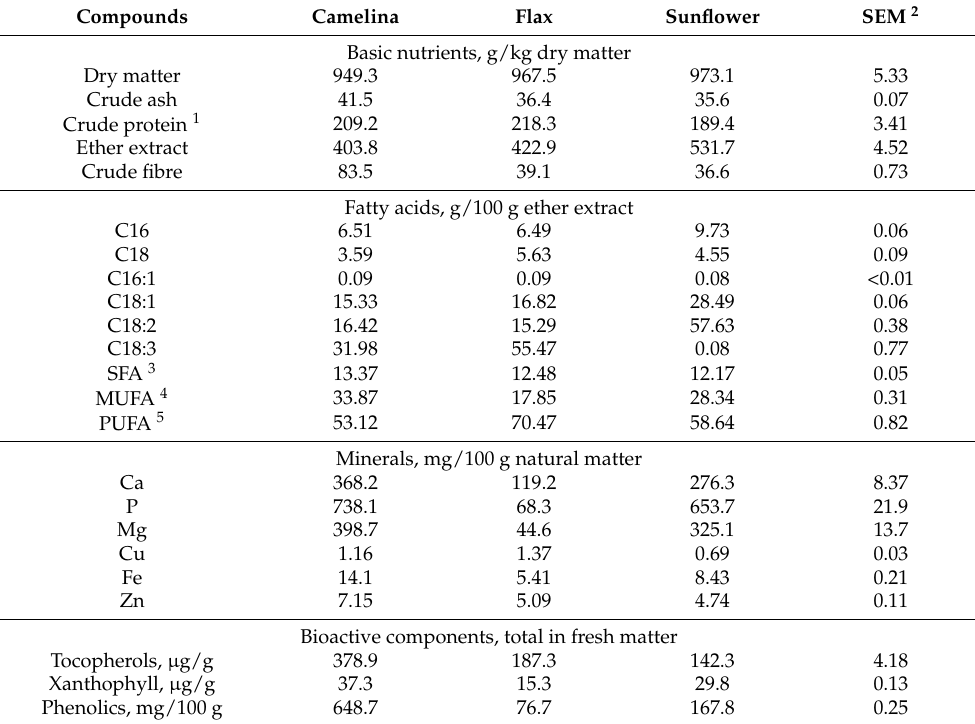
Table 1. Chemical composition of infrared-irradiated camelina, sunflower (dehulled), and flax seeds.